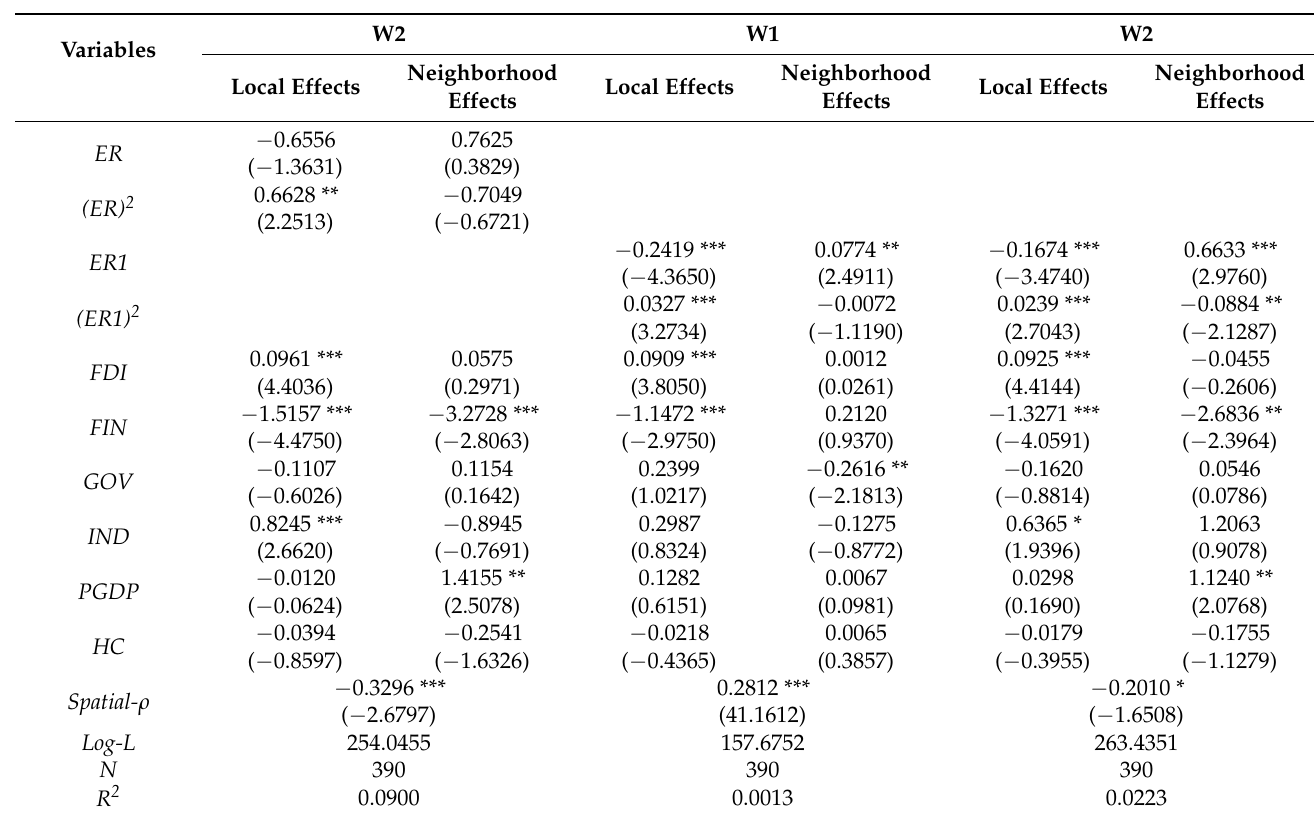
Table 9. Robustness test results.